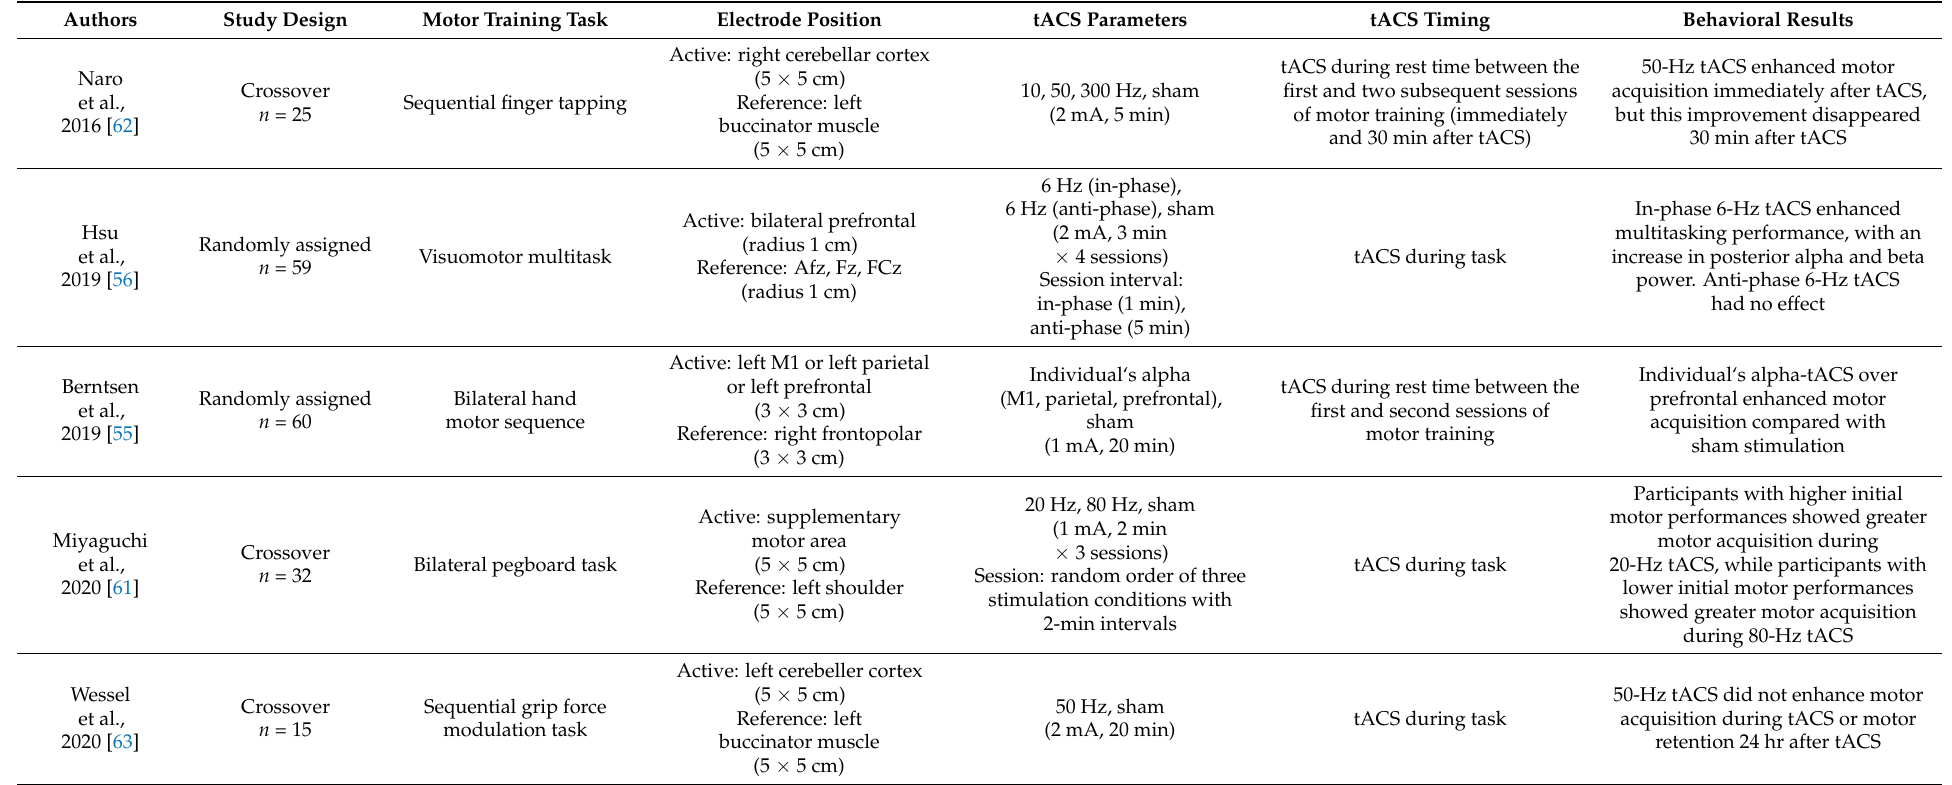
Table 2. Summary of studies applying tACS over non-primary motor cortex or